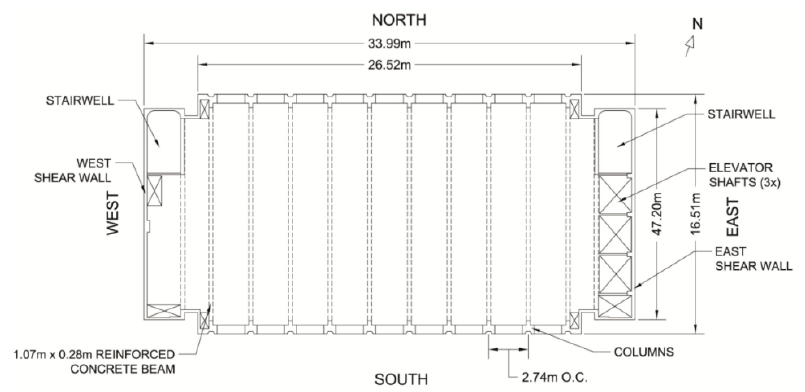
Figure 2. Plan view of a typical floor in the Green Building.